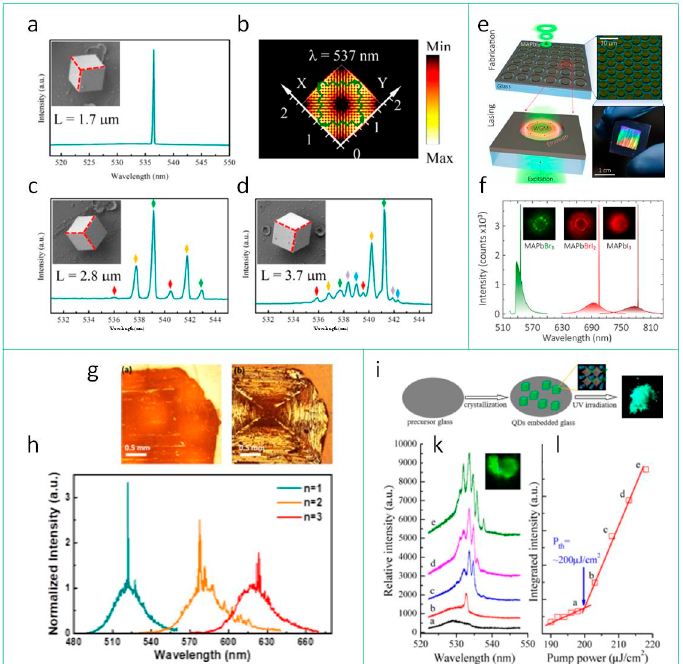
Figure 7. Resonators vs. perovskite material’s morphology. WGM: ( a , c , d ) lasing spectra of the CsPbBr